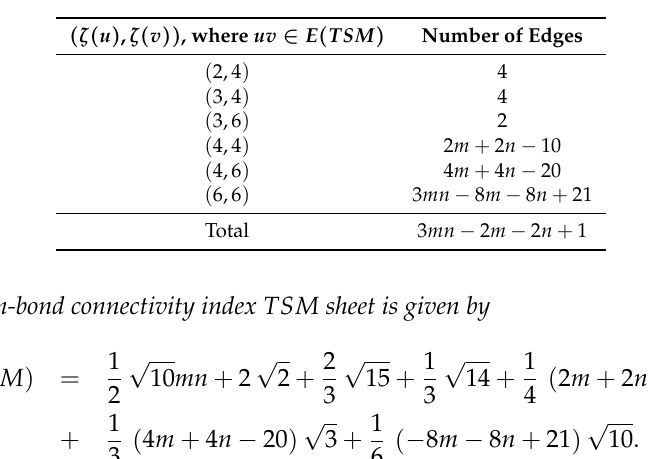
Table 2. The edge partition of a graph TSM sheet based on the degree of end vertices of each